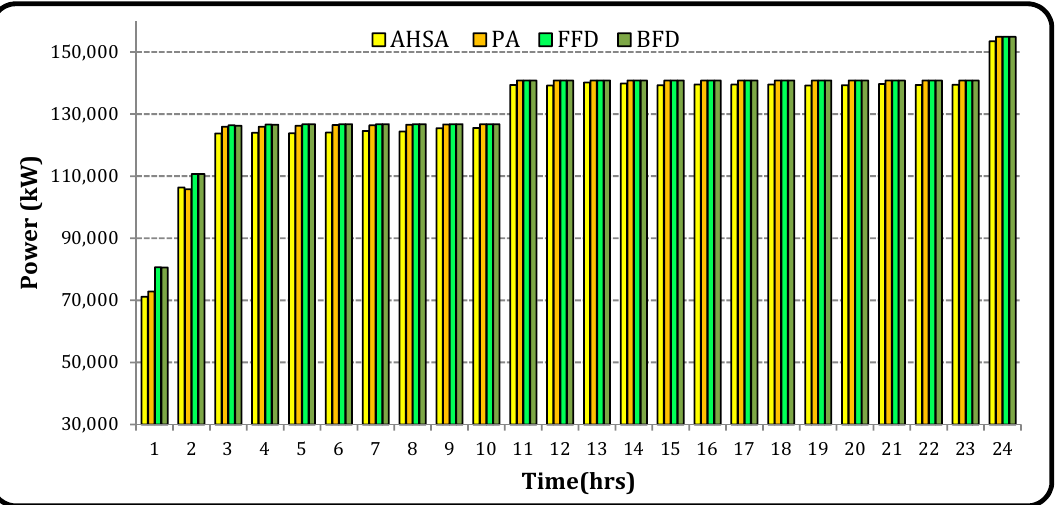
Figure 9. Power consumptions of scenario II for a day.